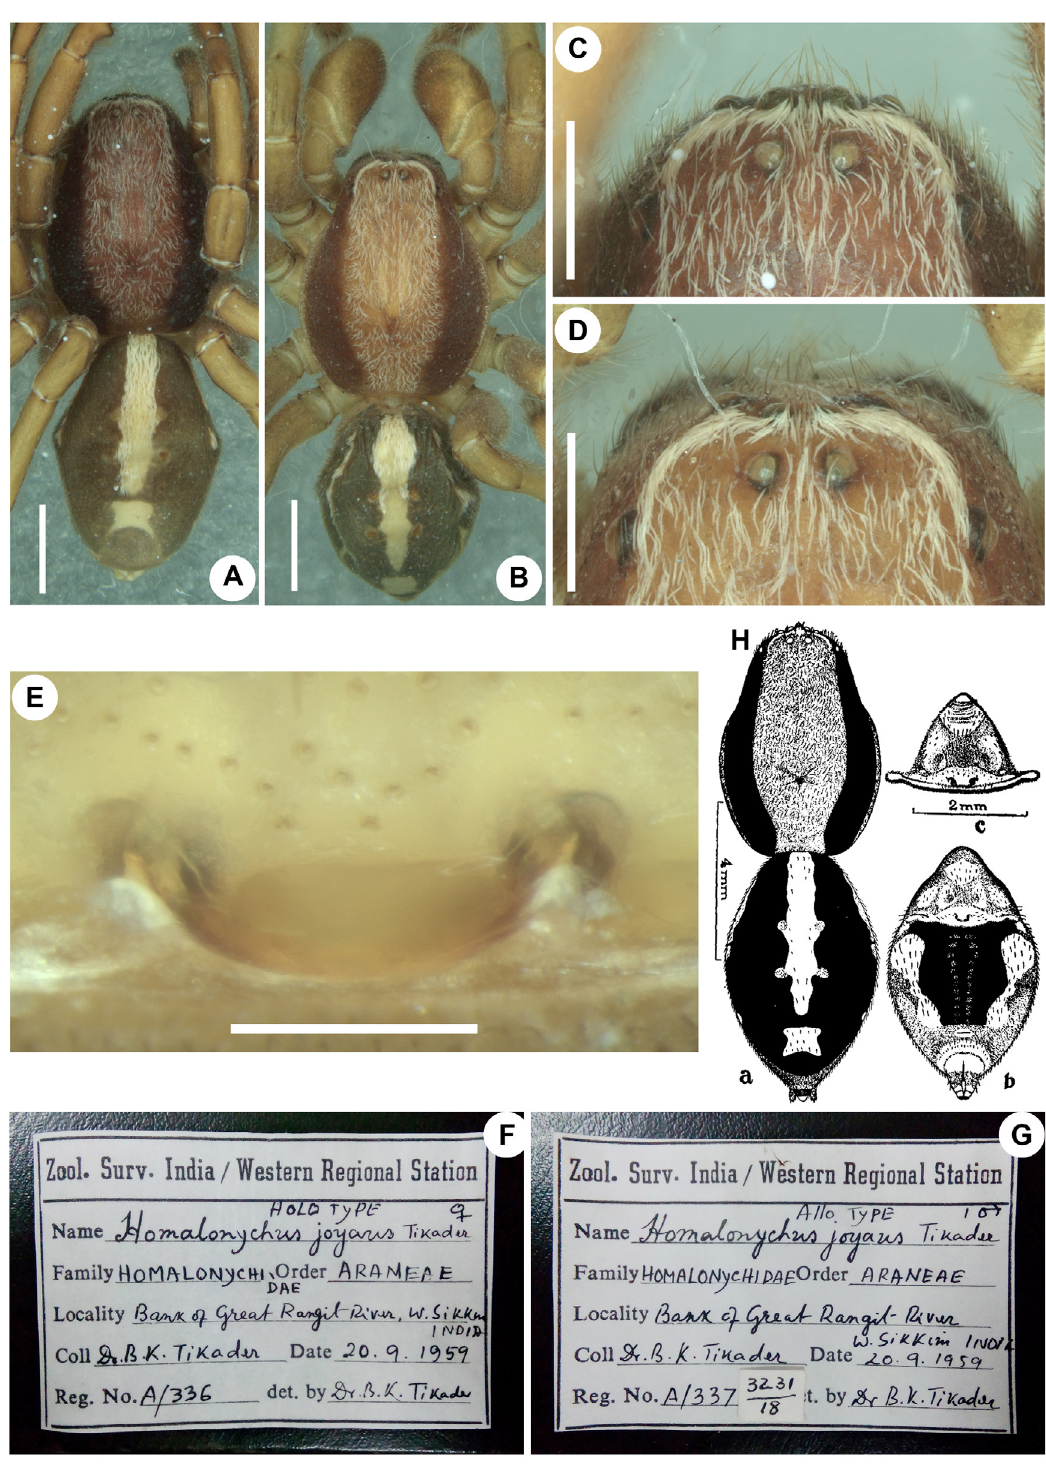
Fig. 12. Storenomorpha joyaus (Tikader, 1970), ♂♀, holotype and allotype of Homalonychus joyaus Tikader, 1970. A , C , E – F . Holotype, ♀ (subadult). A . Habitus, dorsal view. C . Eye group, dorsal view. E . Pre-epigynum, ventral view. F . Type label. B , D , G . Allotype, ♂ (subadult) (NZC-ZSI-3231/18). B . Habitus, dorsal view. D . Eye group, dorsal view. G . Type label. H . Original illustrations of H. joyaus adapted from Tikader (1970). Scale bars: A–B = 2 mm; C–D = 0.5 mm; E = 0.2